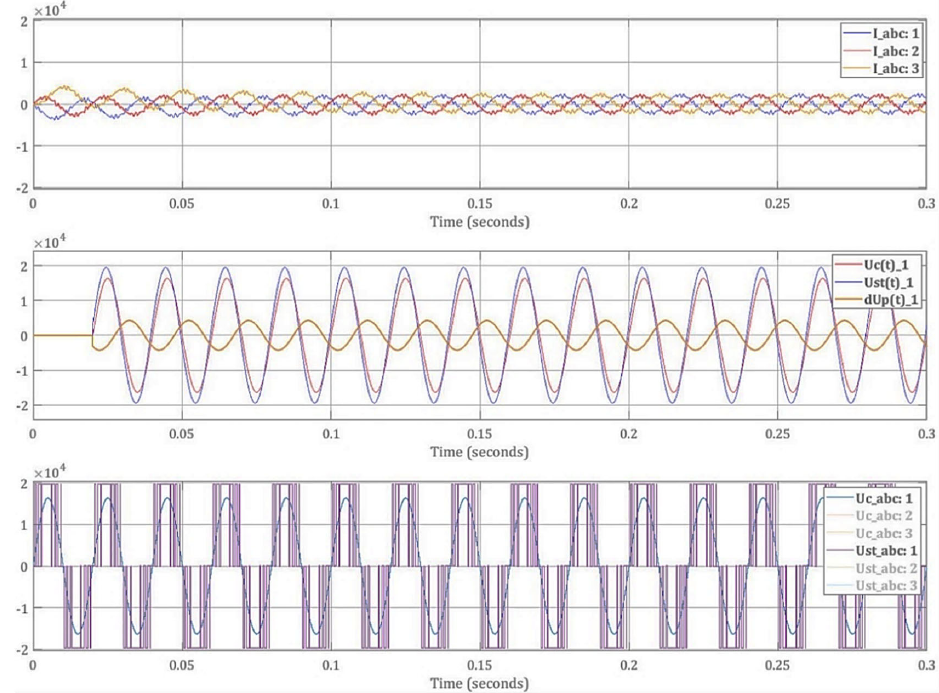
Figure 12. α = 10°, kUst = 1.2—active and reactive power generation. Figure 12. α = 10 ◦ , kUst = 1.2—active and reactive power